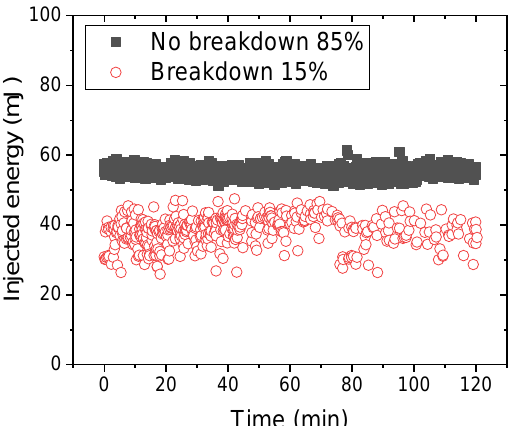
Figure 3. Time evolution of the injected energy per pulse for pin-to-pin discharges in Cr(VI) solution (47 mg/L, σ = 4 mS/cm, pH = 2.3), V = 100 mL, U = 9kV, ∆t = 500 µs, gap = 2 mm, electrode length = 0±10 µm, f = 50 Hz.